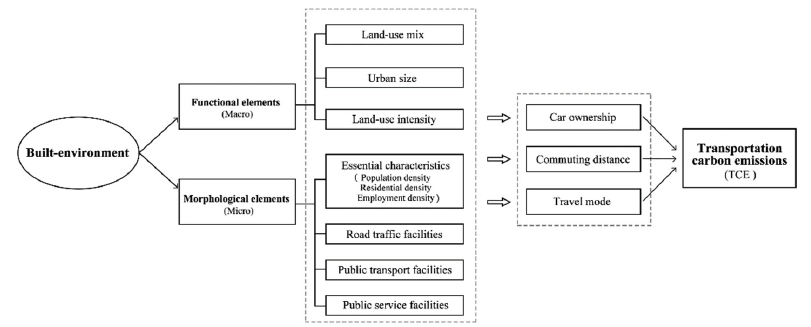
Figure 5. The impact of built-environment on transportation carbon emissions.